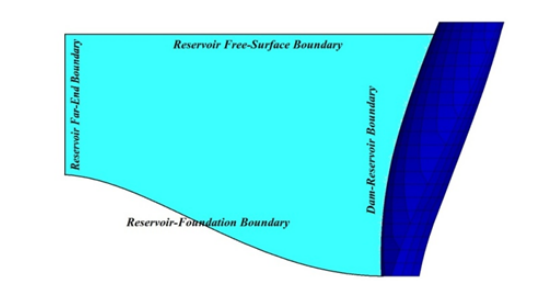
Figure 3. Boundary conditions for